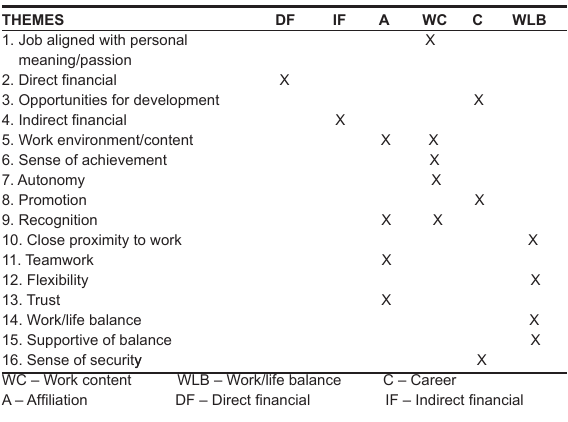
TABLE 3 Comparison between the identified themes and theoretical